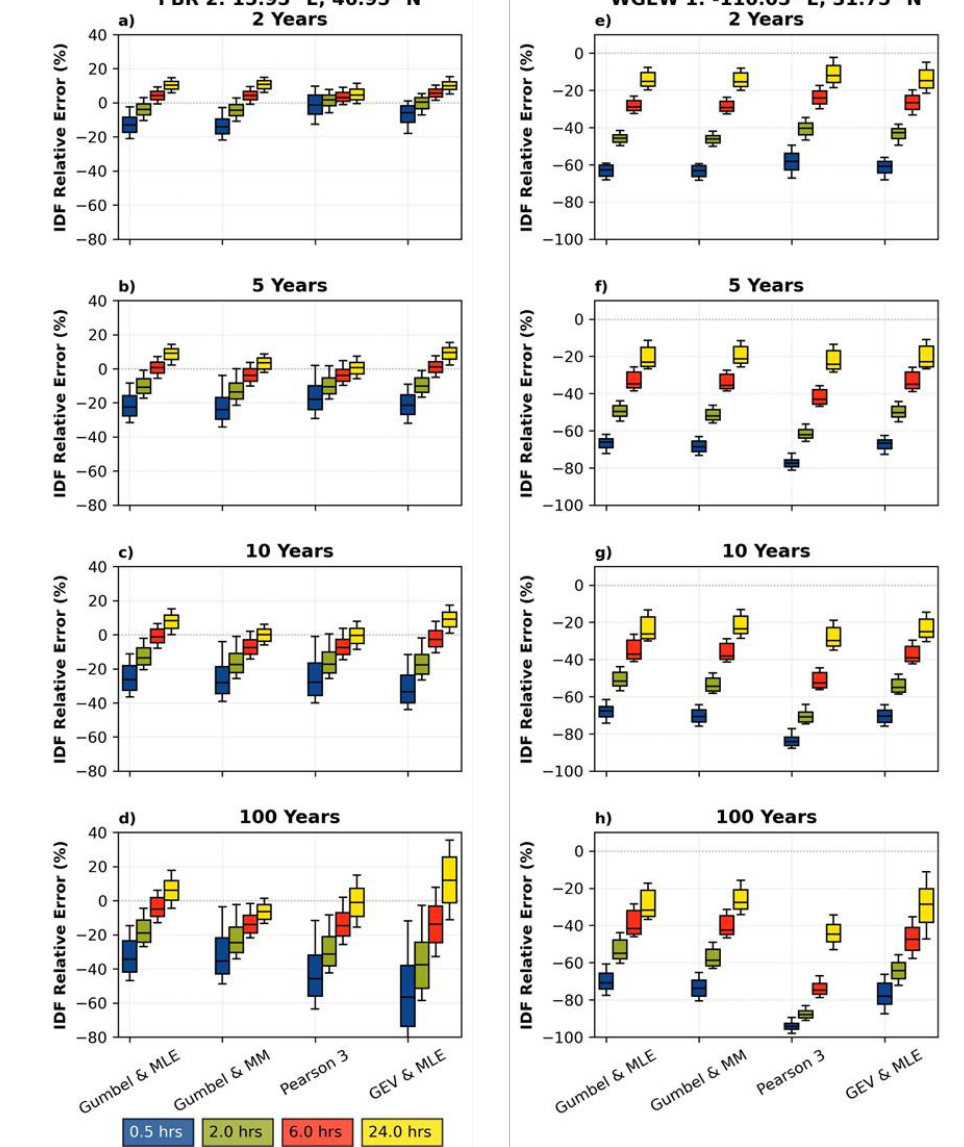
Figure 11. Percent relative error of precipitation AMS from IMERG compared to the gauge-based cells over FBR 2 ( left ) and WGEW 1 ( right ) for durations of 0.5, 2, 6, and 24 h. From top to bottom: for the 2, 5, 10, and 100 year return periods. The lower whiskers are located at the 10th percentile and the upper whiskers at the 90th percentile.